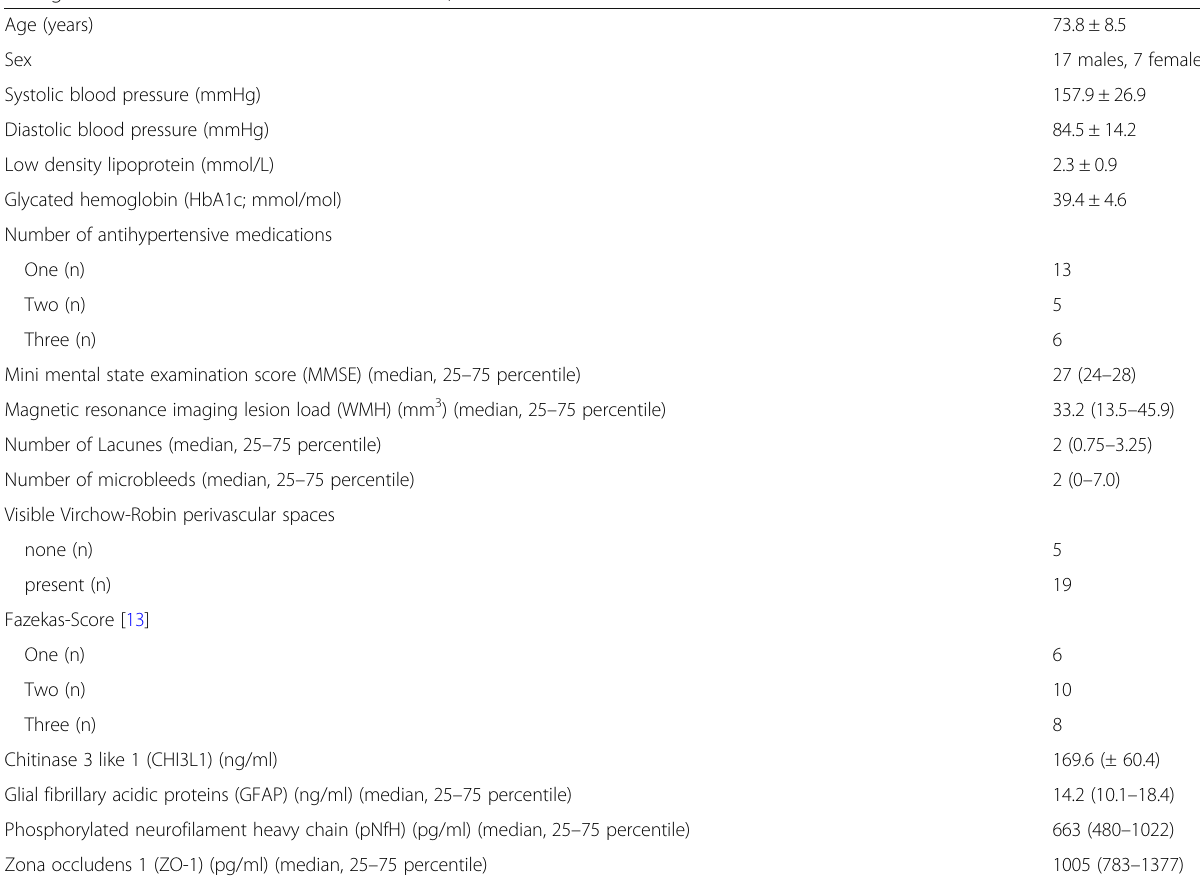
Table 1 Summary of the clinical characteristics and concentrations of CSF-biomarkers assessed in n = 24 CSVD patients (continuous data given as mean ± SD unless otherwise